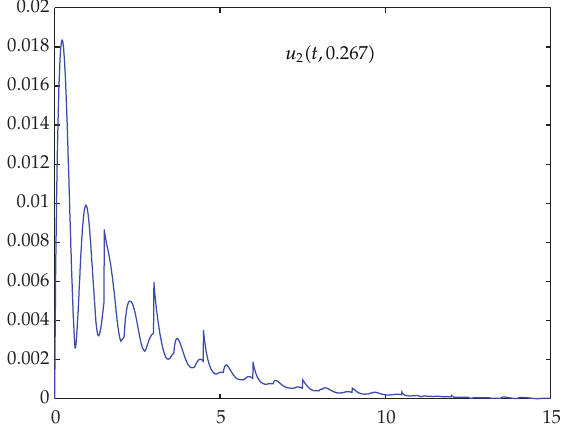
Figure 4: Sectional curve of the state variable u 2 (cid:3) t,x (cid:4)